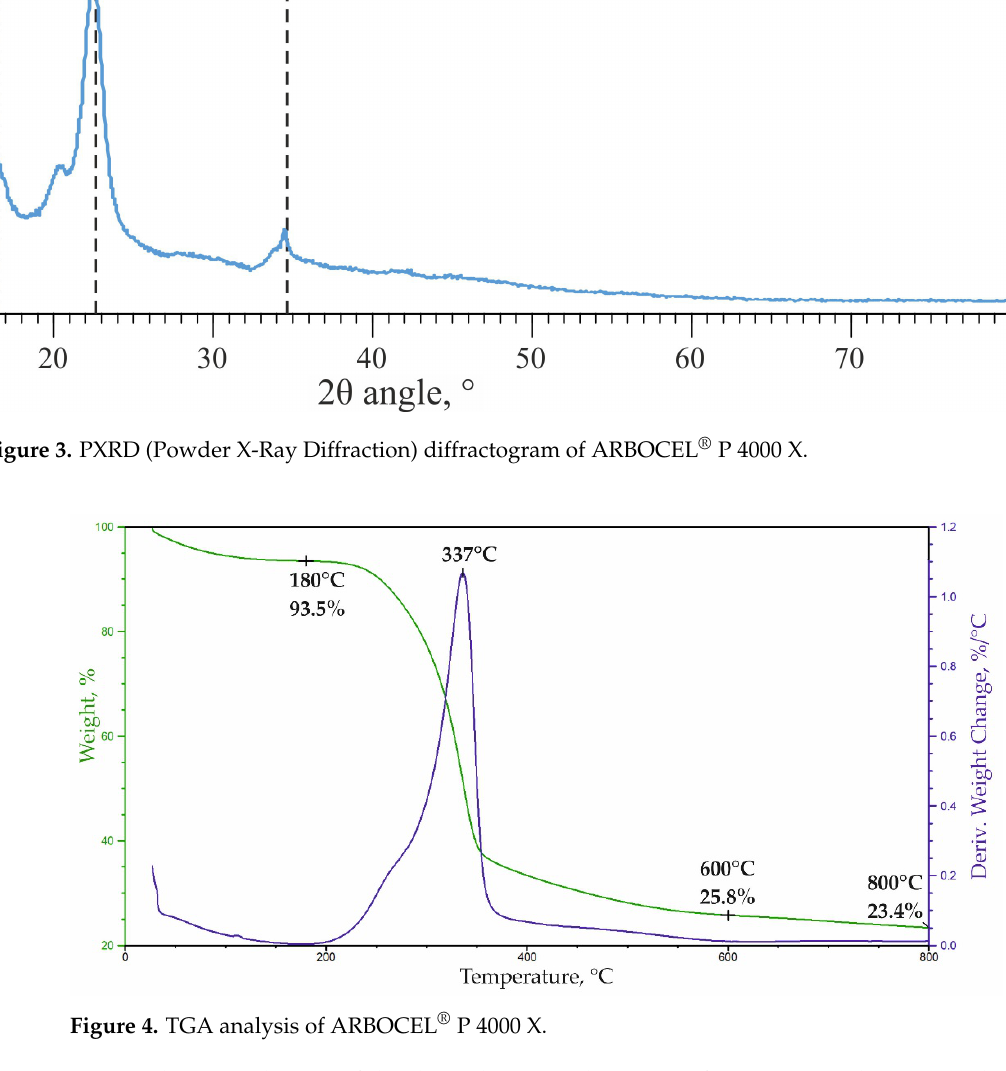
Figure 5. Deconvolution of ARBOCEL ® P 4000 X multiplet peak from DTG analysis into component peaks. Based on the half-area share of the component peaks, the proportion of primary components in ARBOCEL ® P 4000X was calculated, assuming that decompositions of hemicellulose, cellulose and lignin occur in the temperature ranges: 200–330, 250–370, and 350–600 ° C, respectively. The authors of Vaisanen T. et al. [41] obtained similar re- sults. It was found that the lignocellulose in ARBOCEL ® P 4000 X contains approx. 14% of hemicellulose, 49% of cellulose, and 5% of lignin.